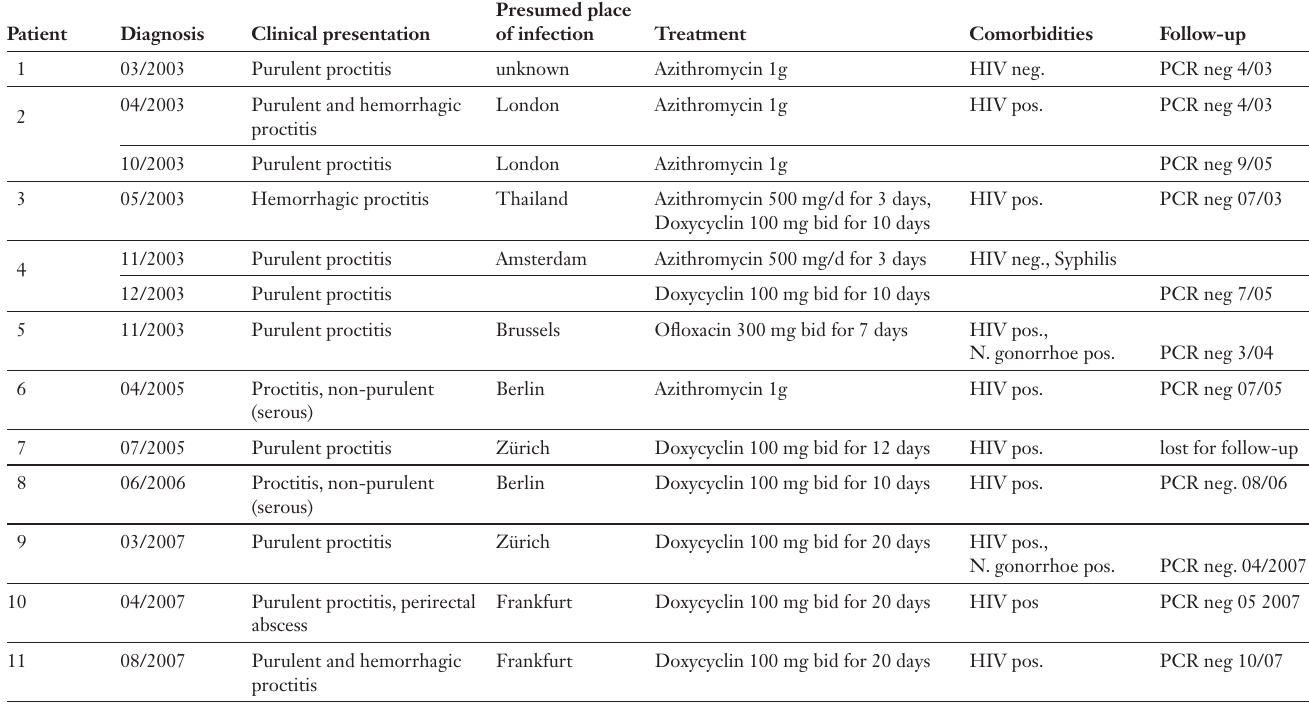
Overview of patient characteristics, treatment and outcome.Total number of positive samples is 13, obtained from 11 patients (patient 2 and patient 4 had two symptomatic episodes and 2 positive samples each).